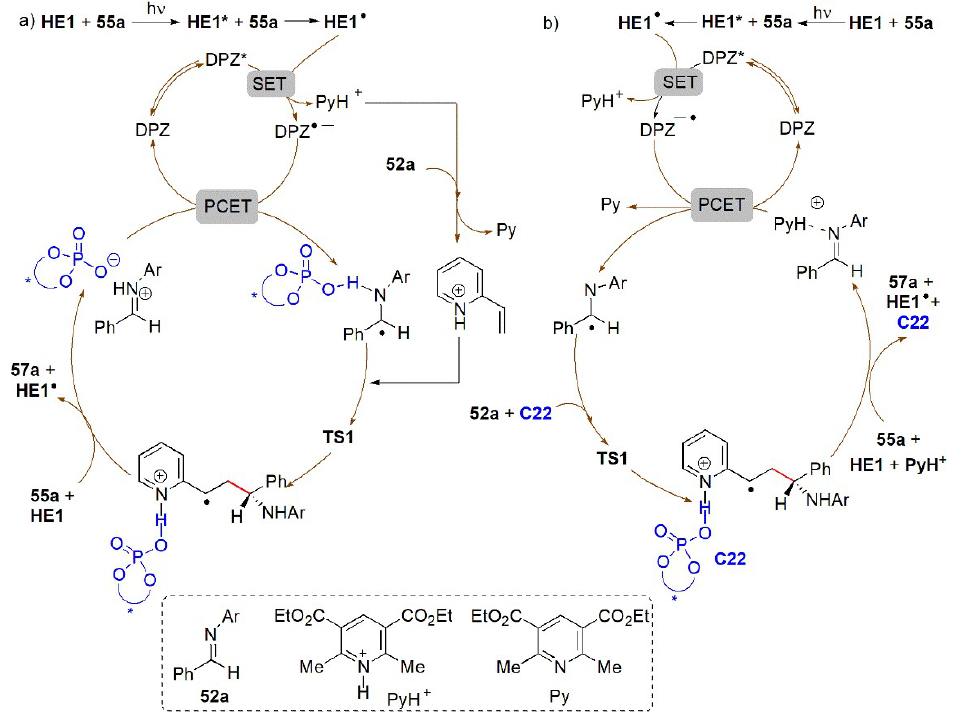
Figure 19. ( a , b ). Alternative mechanisms proposed for the catalytic enantioselective addition of prochiral radicals to vinylpyridines under photoredox conditions and CPA catalysis [87]. In 2019, a method of performing a Han(cid:309)sch ester-mediated Minisci-type C2-alkyla-